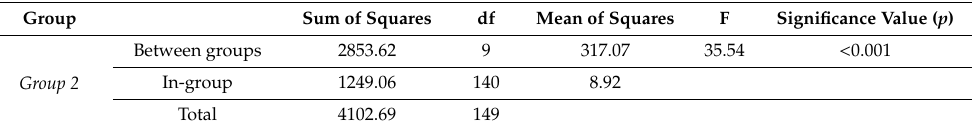
Table 4. Statistical comparison of Group 2 means.